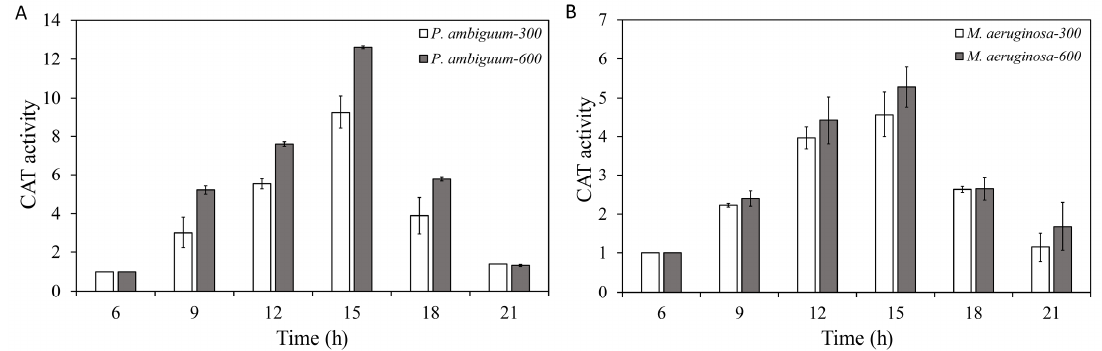
Figure 3. Diurnal variations in the catalase (CAT) activities of P. ambiguum (strain NIES 2119) ( A ) and M. aeruginosa (strain NIES 111) ( B ). The numbers 300 and 600 represent the maximum PAR intensities (in µ mol·m −2 ·s −1 ) for two different treatment conditions, where the maximum PAR intensity was reached at 12:00 h. The error bars represent the standard deviations.